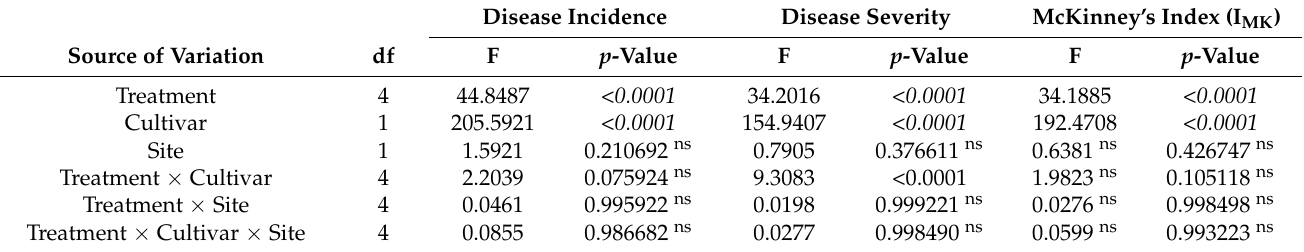
Table 5. Effects of single factors and their interactions in ANOVA on the sour rot infection caused by phytopathogenic bacteria and yeasts on wine grape.